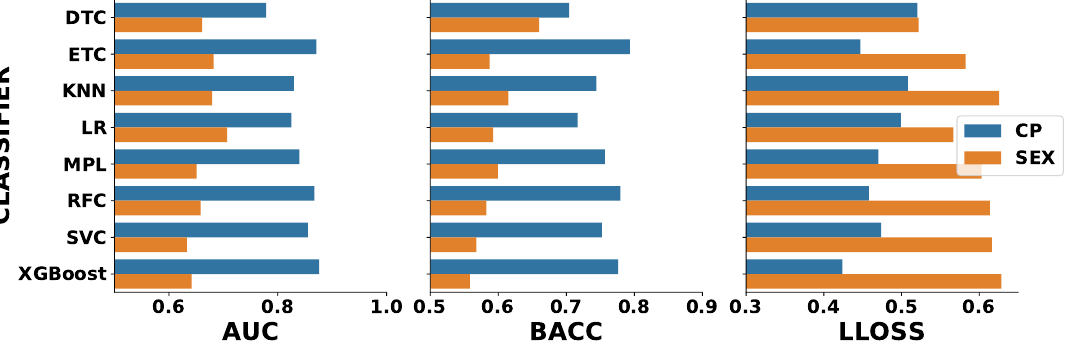
Figure 8. Independent test scores for the best classifiers compared against a hypothetical case where the classifiers were predicting the sex and not the chronic